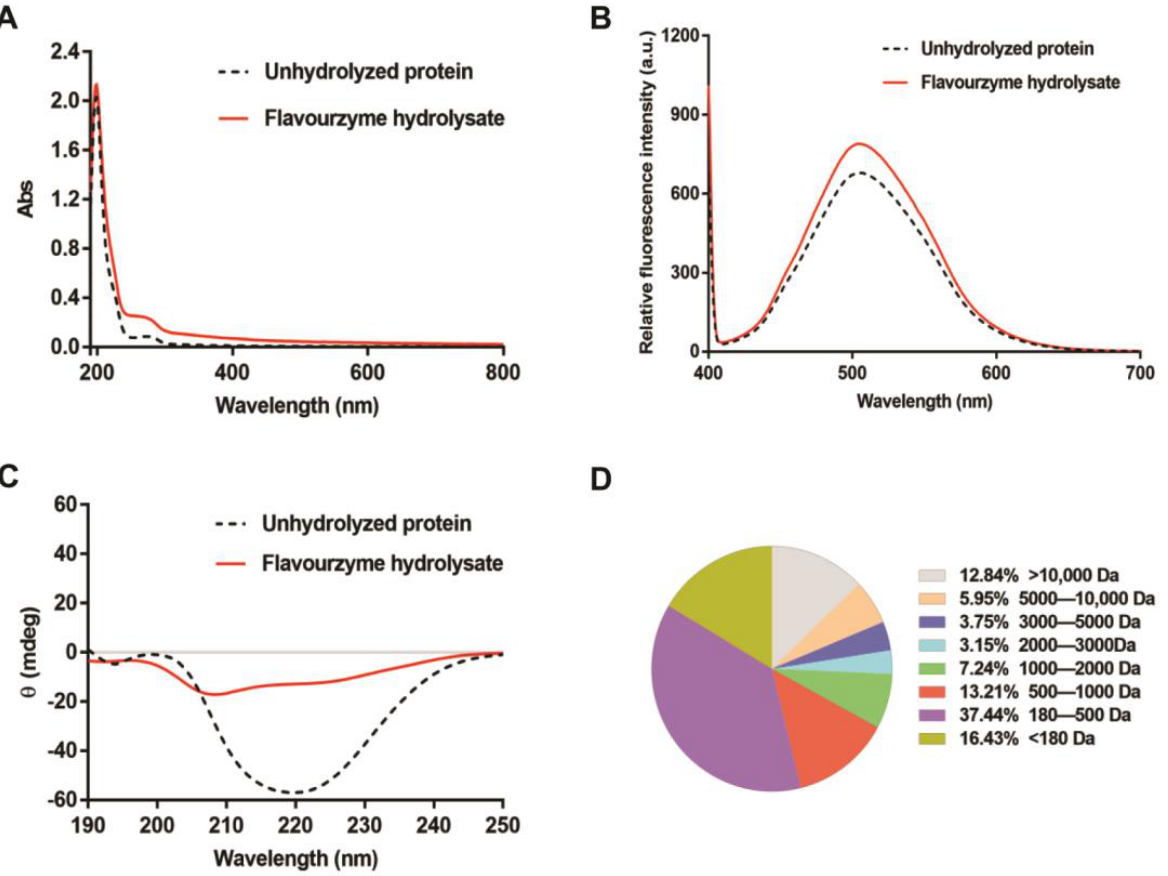
Figure 2. The structural characterization of Tenebrio molitor protein hydrolysates generated by flavourzyme hydrolysis for 4 h. ( A ) UV absorption spectroscopy. ( B ) Relative fluorescence intensity. ( C ) Circular dichroism spectroscopy. ( D ) Molecular weight distribution.